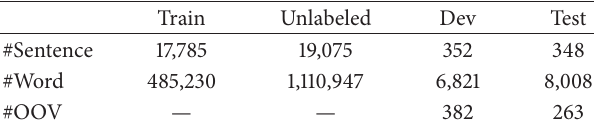
Table 3: The statistics summary of data in CTB-5.0.